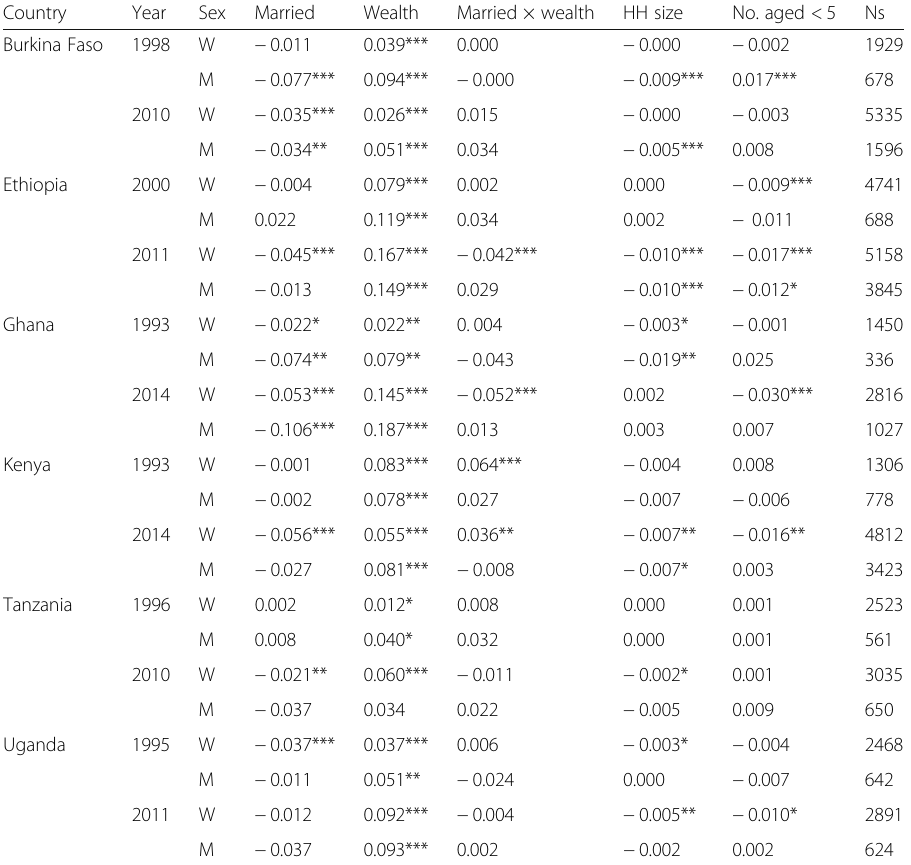
Table 8 Selected LPM regression coefficients: dependent variable: holds a white-collar job Country Year Sex Married Wealth Married × wealth HH size No. aged < 5 Ns Burkina Faso 1998